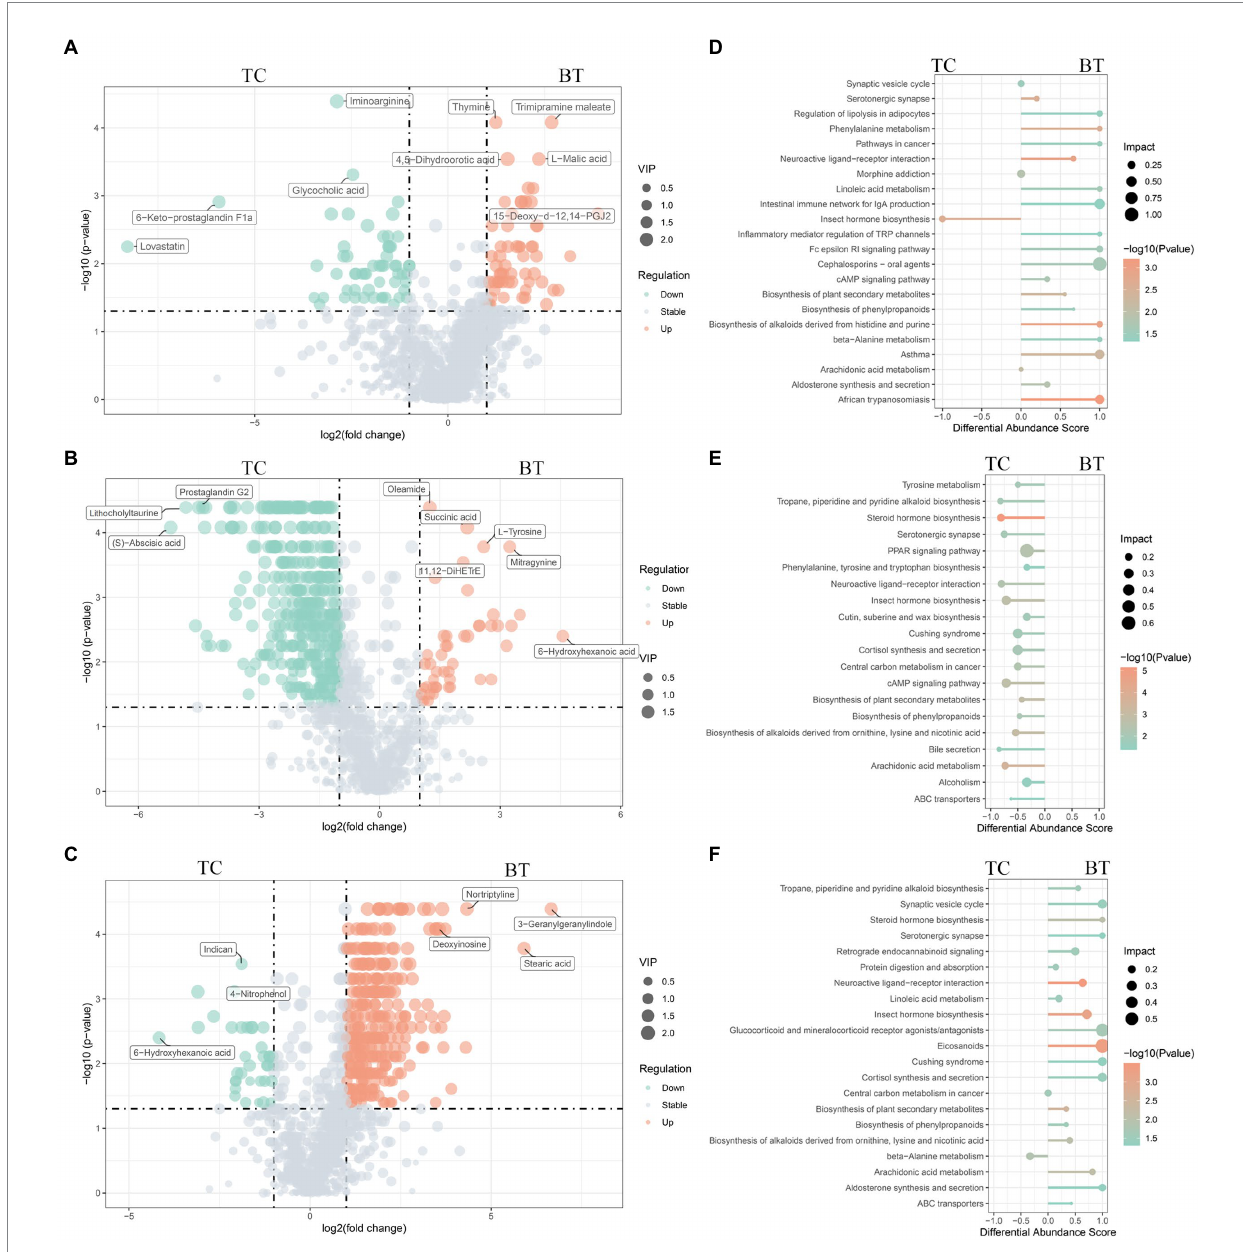
FIGURE 10 Different metabolites and metabolic pathways between TC pigs and BT pigs. Volcano plot of the differential metabolites at (A) the pre-weaning stage, (B) the weaned stage, and (C) the growth stage. Each point represents a metabolite, the points highlighted in green are enriched metabolites of TC pigs while those in red are enriched metabolites of BT pigs, and the size of the point represents the variable importance in projection. Differential metabolic pathways are grouped by (D) pre-weaning stage, (E) weaned stage, and (F) growth stage, the color represents the p, and the size of the point represents the impact